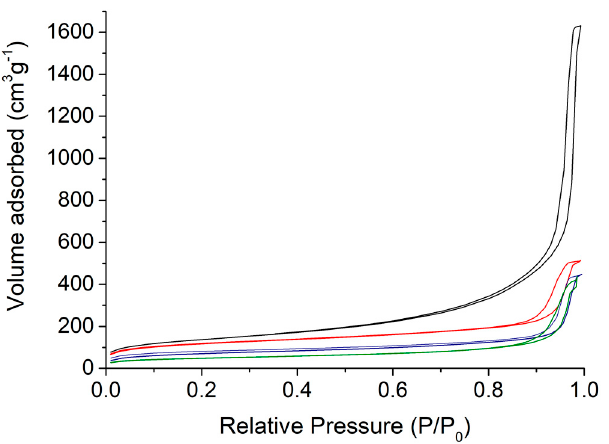
Figure 3. N 2 adsorption isotherms of various silica nanoparticles: MSN (black), MSN-3c (red), MSN-4a (blue) and MSN-4b (green).